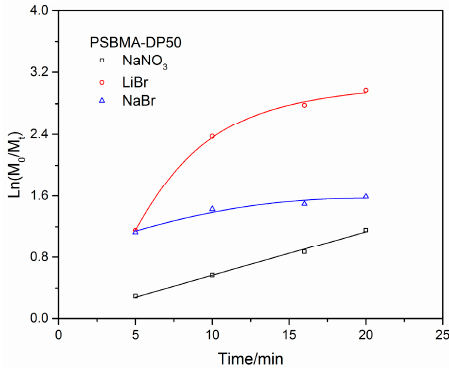
Figure 1. Kinetic plot of Cu 0 -mediated LRP of SBMA with target DP of 50 in different salt solution (the solid line is a guide to eye).